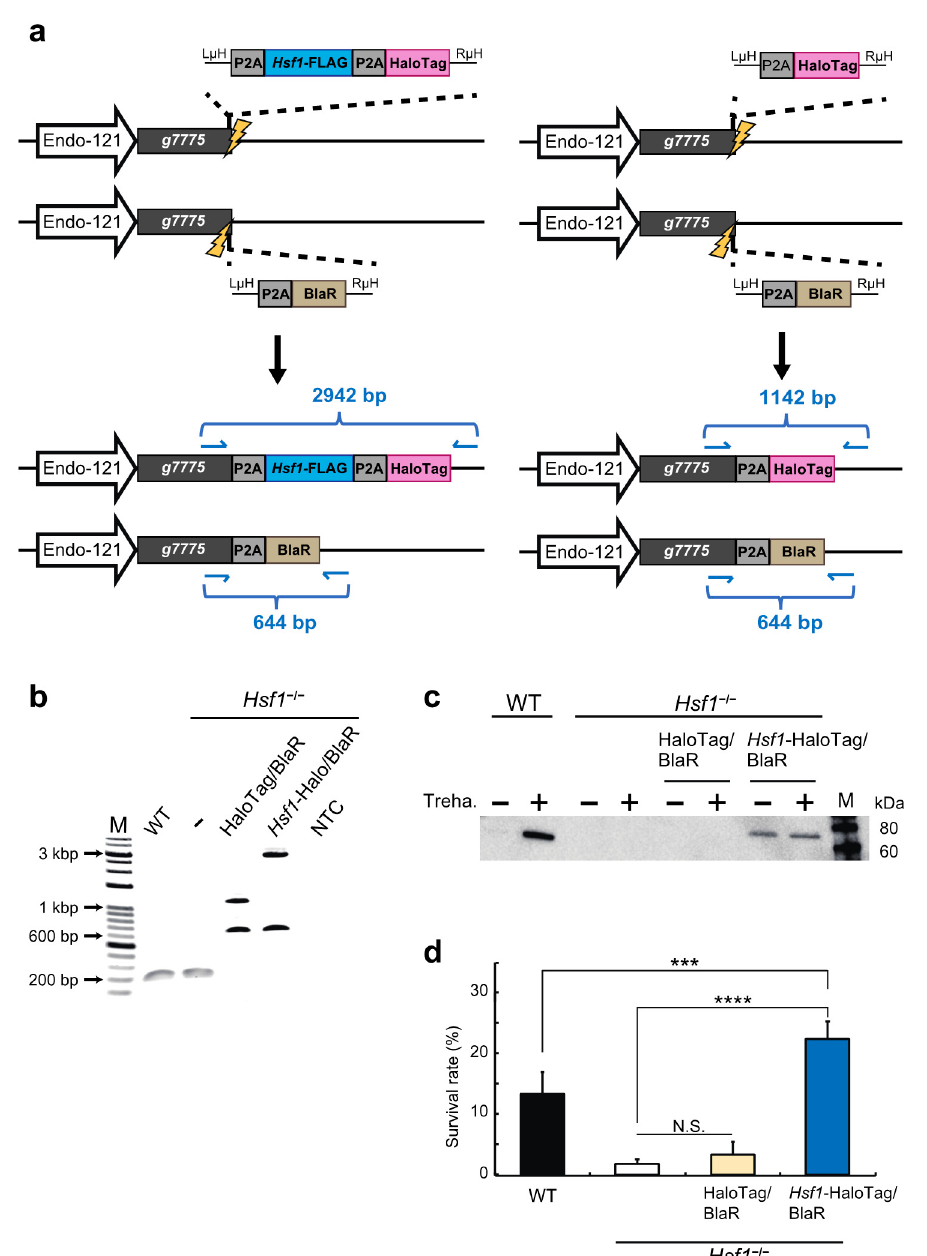
Figure 2. Establishment of an HSF1-rescue cell line: ( a ) Schematic diagram of the knock-in of either Hsf1 -FLAG-P2A-HaloTag plus BlaR or HaloTag alone plus BlaR into Hsf1 − / − cells using the CRIS-PITCh system. These genes were knocked into the 5 ′ flanking site of the stop codon of the g7775 gene. The HaloTag-plus-BlaR knock-in cell line was established as a negative control for the HSF1-rescue cell line. The thin blue arrows show the primer binding sites for genomic PCR. The primer sequences are given in Data S2 and S3. Endo-121, endogenous 121-promoter; L µ H and R µ H, left and right microhomology, respectively; ( b ) PCR analysis of Hsf1 − / − ; HaloTag/BlaR and Hsf1 − / − ; Hsf1 -HaloTag/BlaR cell lines. The product sizes of WT, Hsf1 − / − , HaloTag, BlaR and Hsf1 -FLAG-P2A-HaloTag are 181 bp, 1142 bp, 644 bp and 2942 bp, respectively. The respective genome sequences are given in Data S2 and S3. M, molecular size markers; WT, wild type Pv11 cells; NTC, no-template control; ( c ) Western blotting analysis of Hsf1 − / − ; HaloTag/BlaR and Hsf1 − / − ; Hsf1 -HaloTag/BlaR cells using HSF1 antibody. The same membrane stained with ponceau S to validate protein transfer is shown in Figure S2; ( d ) survival rate after desiccation-rehydration of Hsf1 − / − ; HaloTag/BlaR and Hsf1 − / − ; Hsf1 -HaloTag/BlaR cells. The number of live cells was counted one day after rehydration. Normalized values are expressed as mean ± SD. *** p < 0.001; **** p < 0.0001; N.S., not significant; n = 5 in each